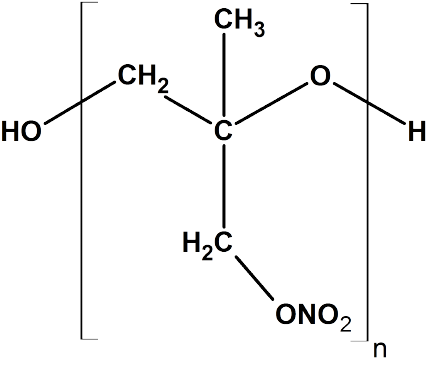
Figure 4. Chemical structure of